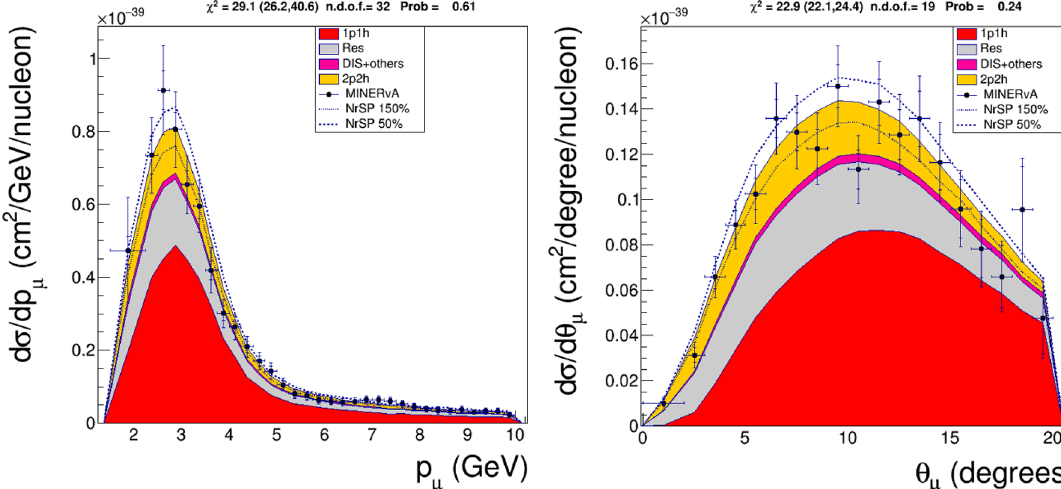
Figure 12 . Inclusive | ~p µ | (left) and θ µ (right) distributions from the CC 0 π 1 p MINERvA sample [15, 19, 20]. Details of the comparison with NEUT results as in figure 8.